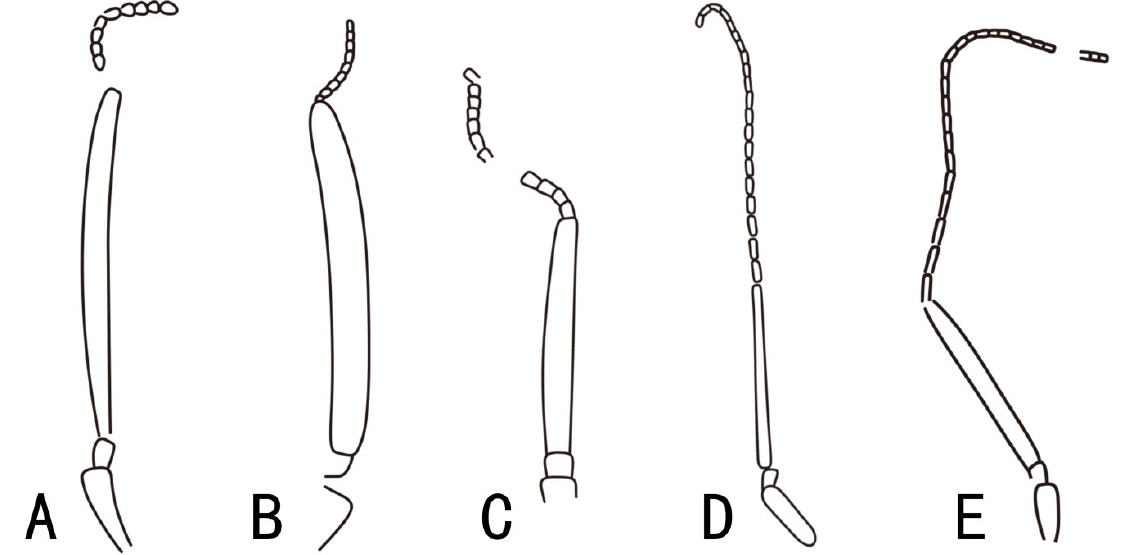
Figure 4. Different types of antennae in the subfamily Macroxyelinae. ( A ), Isoxyela rudis Zhang and Zhang, 2000. ( B ), Gigantoxyela quadrifurcata Rasnitsyn, 1966. ( C ), Scleroxyela daohugouensis Zheng et al., 2021. ( D ), Leptoxyela eximia gen. et sp. nov. ( E ), Ceratoxyela decorosa Zhang and Zhang, 2000. Remarks. Scleroxyela cephalota sp. nov. can be assigned to the subfamily Macroxyelinae based on the pterostigma slerotised and with sclerotisation connecting C and R